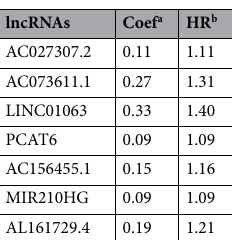
Table 1. The 7 lncRNAs for construction of prognosis model. a Coefficients. b Hazard